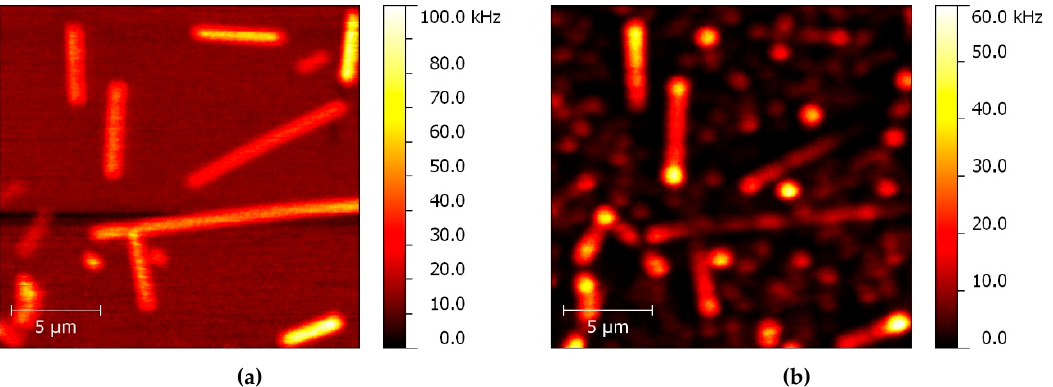
Figure 7. ( a ) Scattering image obtained for silver nanowires coated with up-converting nanocrystals, and ( b ) luminescence map collected for the same sample area upon excitation at 980 nm and detection at 650 nm.